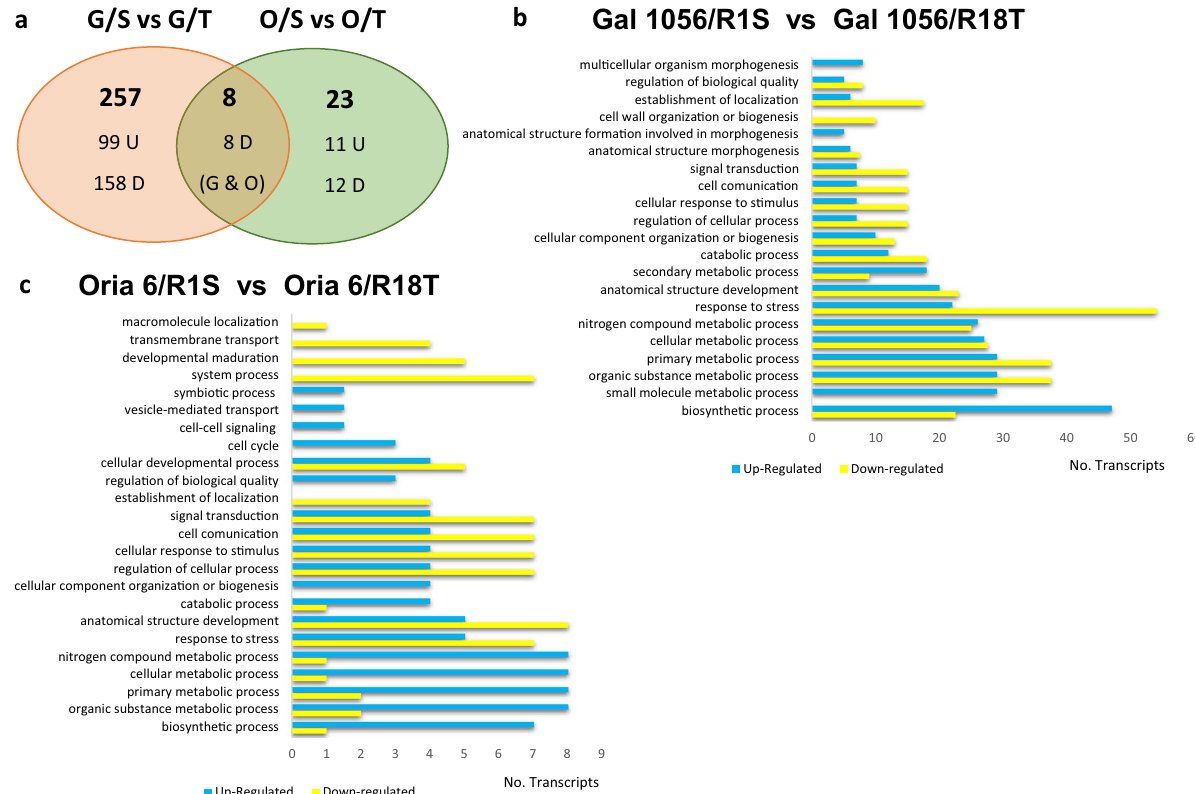
Figure 2. DEGs identified in needles of drought-sensitive (G: Gal 1056) or drought-tolerant (O: Oria 6) scions grafted onto drought-sensitive (S: R1S) versus drought-tolerant (T: R18T) rootstocks. ( a ) Venn diagram showing DEGs [Log2FC ≤ − 1.5 and Log2FC ≥ 1.5] for upregulated (U) and downregulated DEGs (D), respectively. ( b – c ) Histogram presentation of GO terms enriched in significantly upregulated (blue) and downregulated (yellow) genes exclusively differentially expressed in G/S versus G/T ( b ) or O/S versus O/T ( c ) scions. P values ( P < 0.05) were calculated according to the Wald